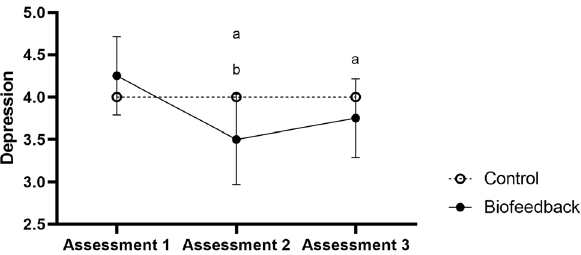
Figure 1. Symptoms of depression during assessments 1, 2, and 3 in the group that received biofeedback training (solid black line) and in the group that received the control training (dotted black line) in the non- institutionalized sample. a Significant difference of assessment 2 and 3 in comparison to assessment 1 (< 0.05) and b significant differences between groups (<